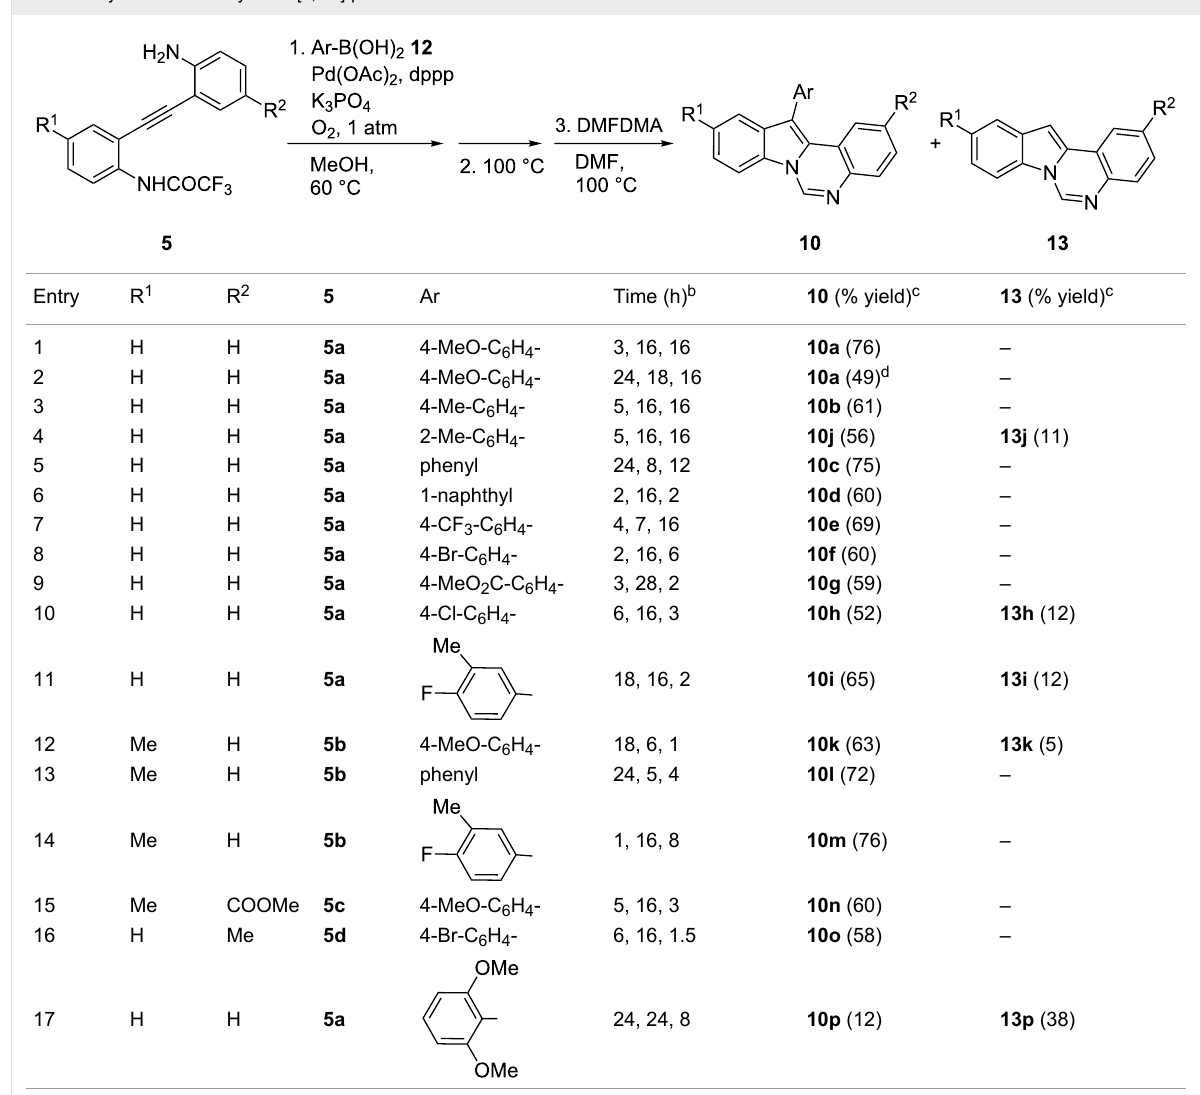
Table 1: Synthesis of 12-arylindolo[1,2- c ]quinazolines 10 .